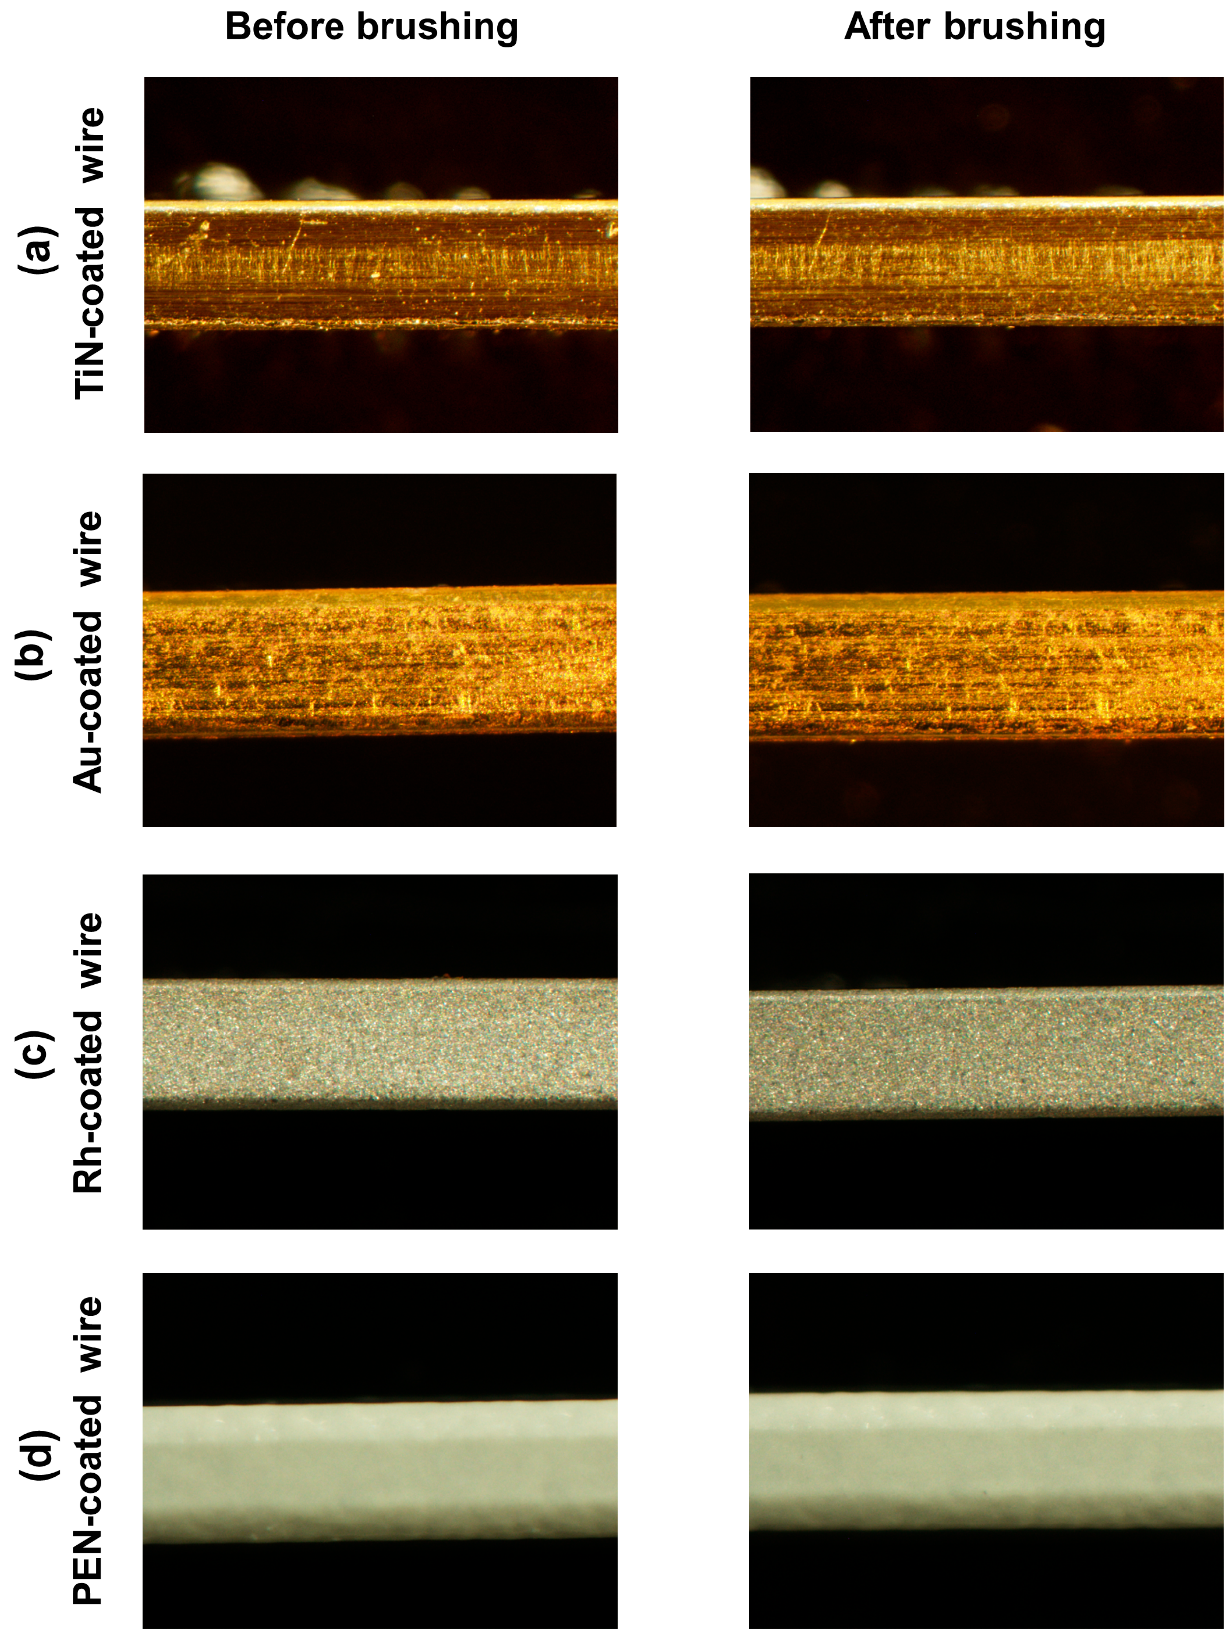
Figure 6. Stereomicrographs of four types of coated wire before and after brushing: ( a ) TiN-coated wire; ( b ) Au-coated wire; ( c ) Rh-coated wire; ( d ) PEN-coated wire.